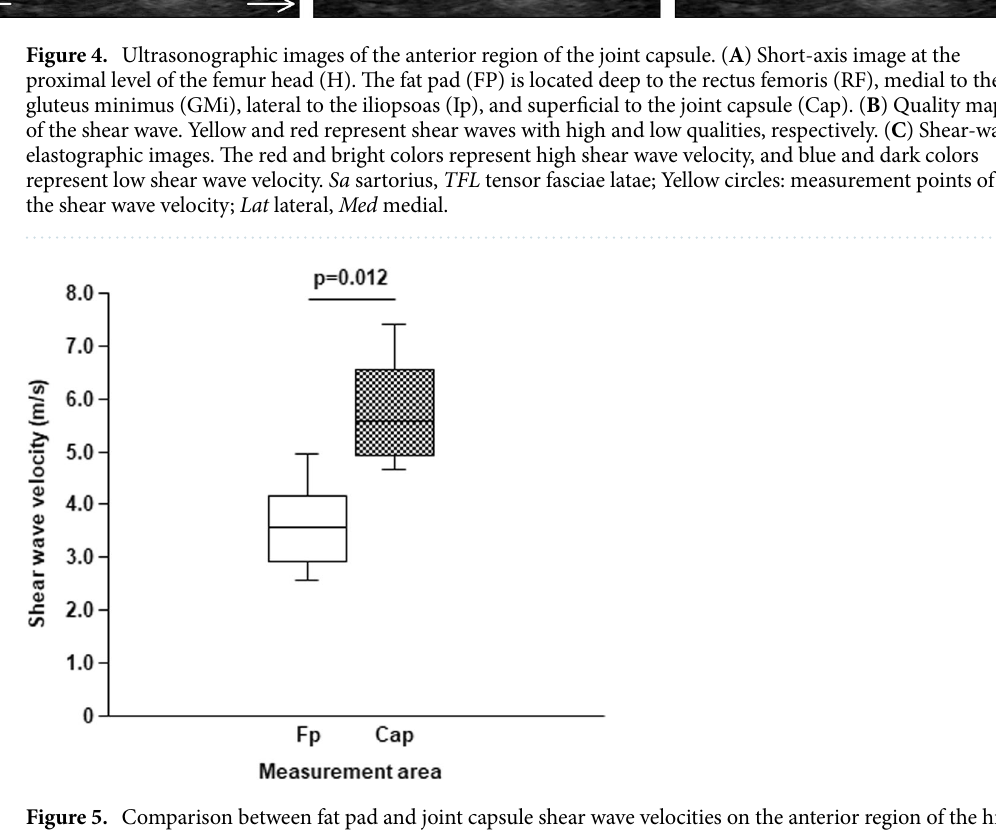
Figure 5. Comparison between fat pad and joint capsule shear wave velocities on the anterior region of the hip. The shear wave velocity in the fat pad (Fp) was significantly lower than that in the joint capsule